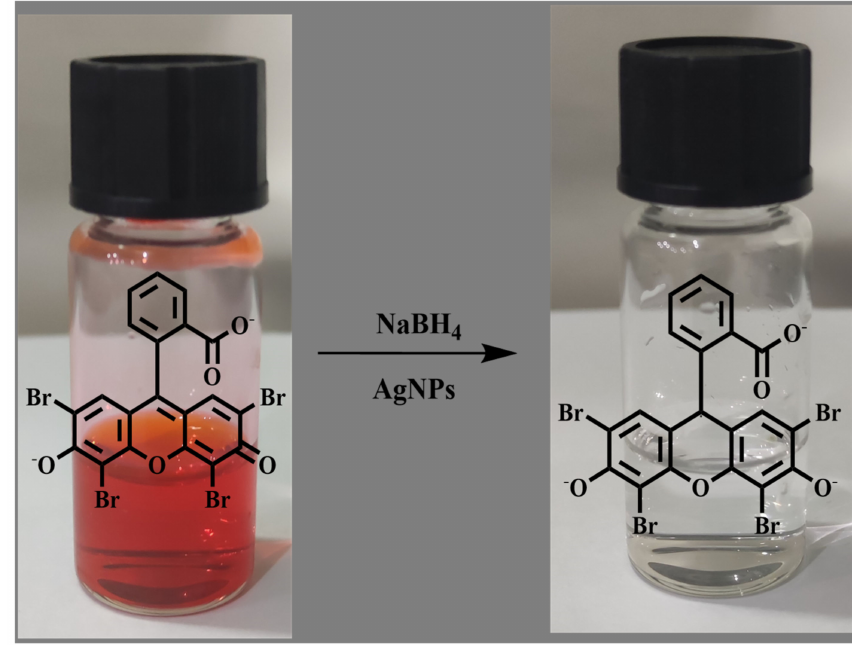
Figure 21. Possible mechanism of catalytic degradation of Eosin